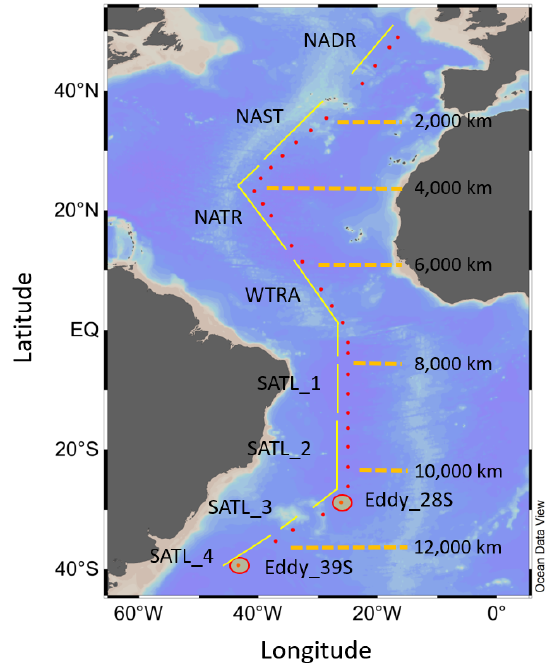
Figure 1. Map of the study area, indicating the positions of sam- pling stations for N-cycle studies (red dots), the approximate tran- sect distances, and the associated Longhurst provinces (Longhurst, 1998); North Atlantic Drift (NADR), North Atlantic sub-tropical gyre (NAST), North Atlantic tropical gyre (NATR), western tropi- cal Atlantic (WTRA), South Atlantic gyre (SATL). The locations of two eddy features are also